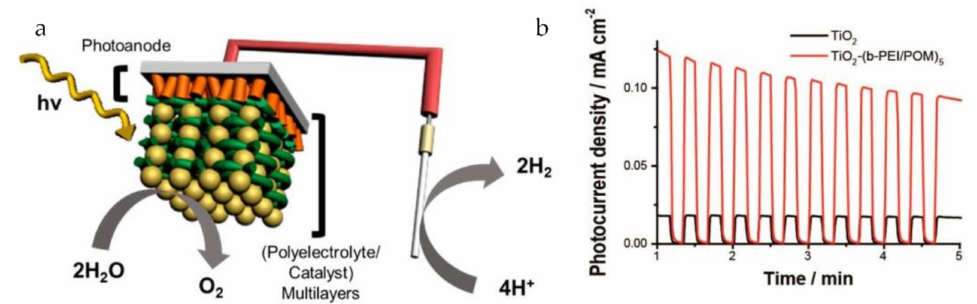
Figure 9. ( a ) The experimental procedure and the functional components used in this study is graphically illustrated. ( b ) TiO 2 photoanodes was studied by measuring LSV and photocurrent density with and without light irradiation. Reprinted with permission from [108]. Copyright (2017) American Chemical